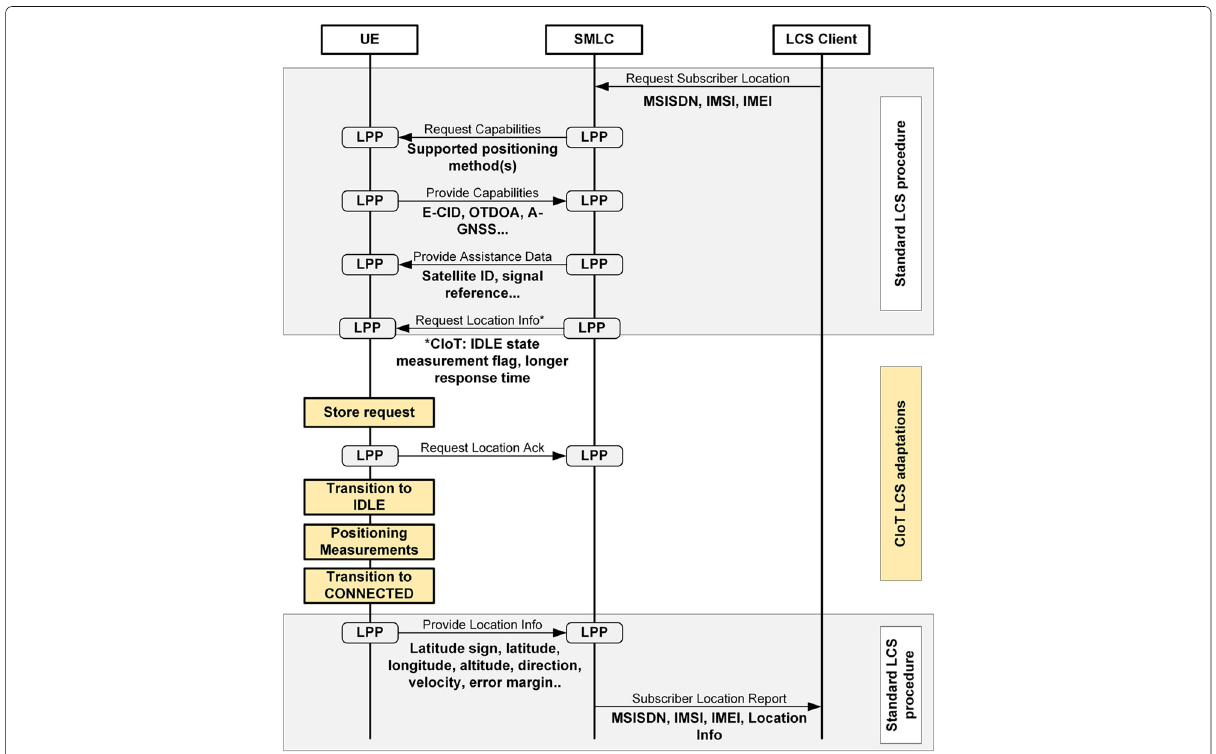
Fig. 16 LALS integration with the CIoT architecture. SMLC must allow for IDLE state measurement for computational and power-restricted CIoT